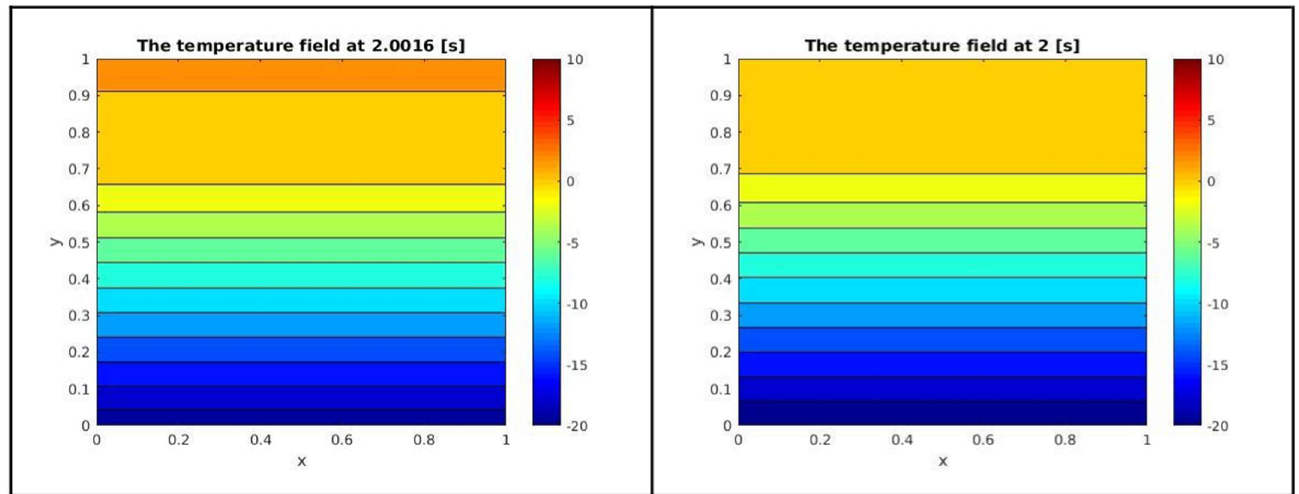
Figure 4. Temperature field distribution within a soil profile at a specific time of the simulations. On the left, distribution obtained with the present method and on the right, distribution obtained with the explicit method.